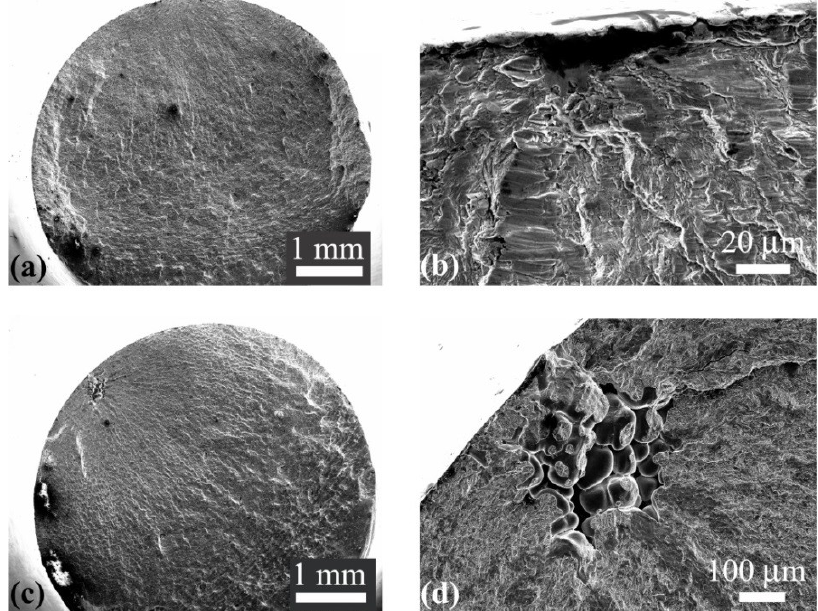
Figure 4. SEM images of the fracture surface for hourglass specimens with single-site crack initiation. ( a , b ): local stress amplitude σ a = 315 MPa, N = 1.73 × 10 5 ; ( c , d ): local stress amplitude σ a = 252 MPa, N = 1.37 × 10 5 .